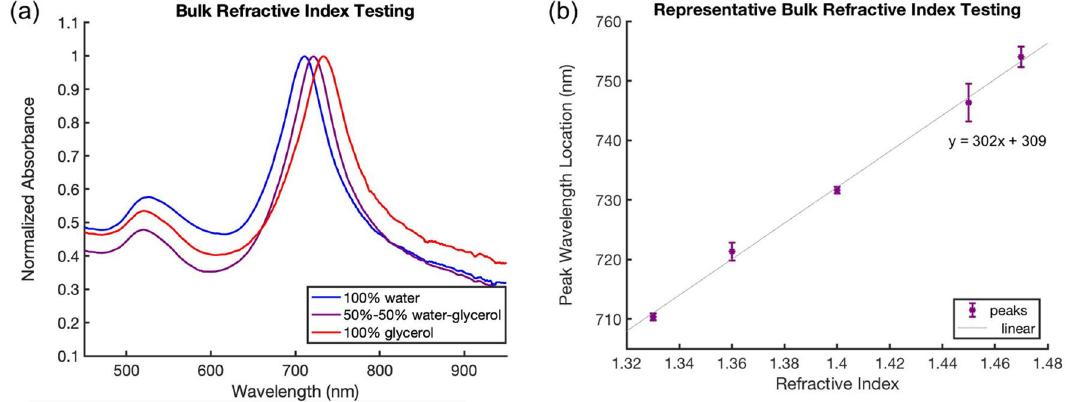
Figure 5. Example of bulk refractive index testing for nanobipyramids. Water-glycerol mixtures were put in contact with nanoparticles—0% glycerol in water (RI = 1.33), 20% glycerol in water (RI = 1.36), 50% glycerol in water (RI = 1.4), 80% glycerol in water (RI = 1.45), 100% glycerol (RI = 1.47). ( a ) Data demonstrating red shifts in resonance peak with increasing glycerol concentration (i.e. increased refractive index). ( b ) Data showing how bulk refractive index sensitivity is calculated based upon the longitudinal peak location. The peak locations are plotted as a function of refractive index. These data for nanobipyramids have a refractive index sensitivity of 302 nm/RIU.